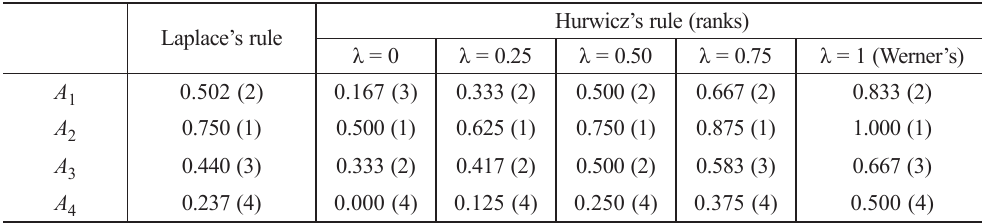
Table 7. Results of the Laplace’s and Hurwicz’s rules Hurwicz’s rule (ranks) Laplace’s rule λ = 0